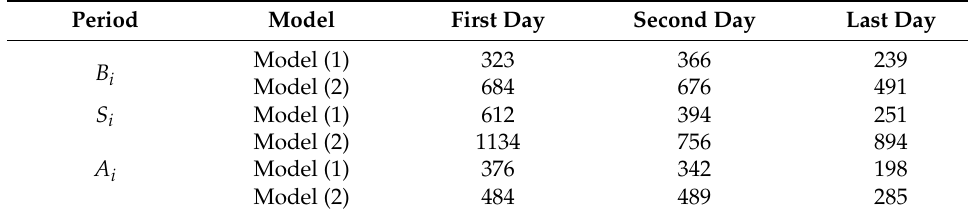
Table 9. The number of customers waiting in the three periods.